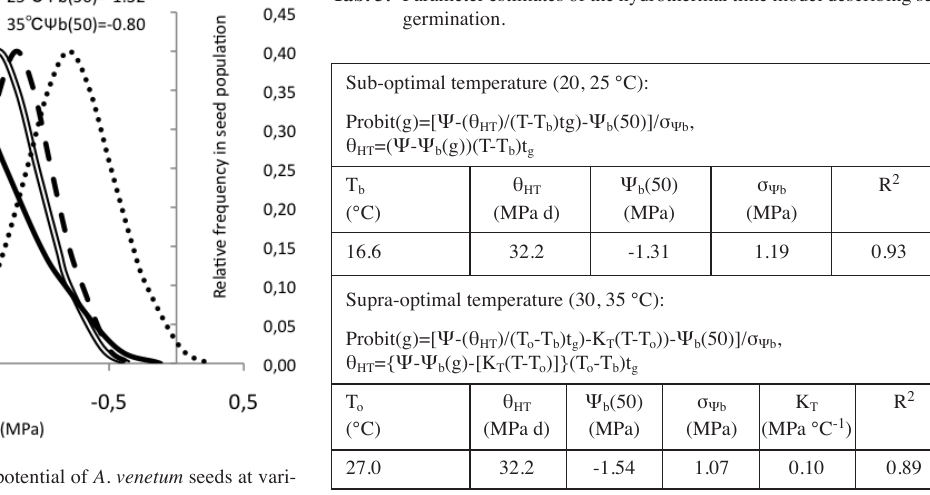
Fig. 3: Distribution of the base water potential of A. venetum seeds at vari- ous temperatures.